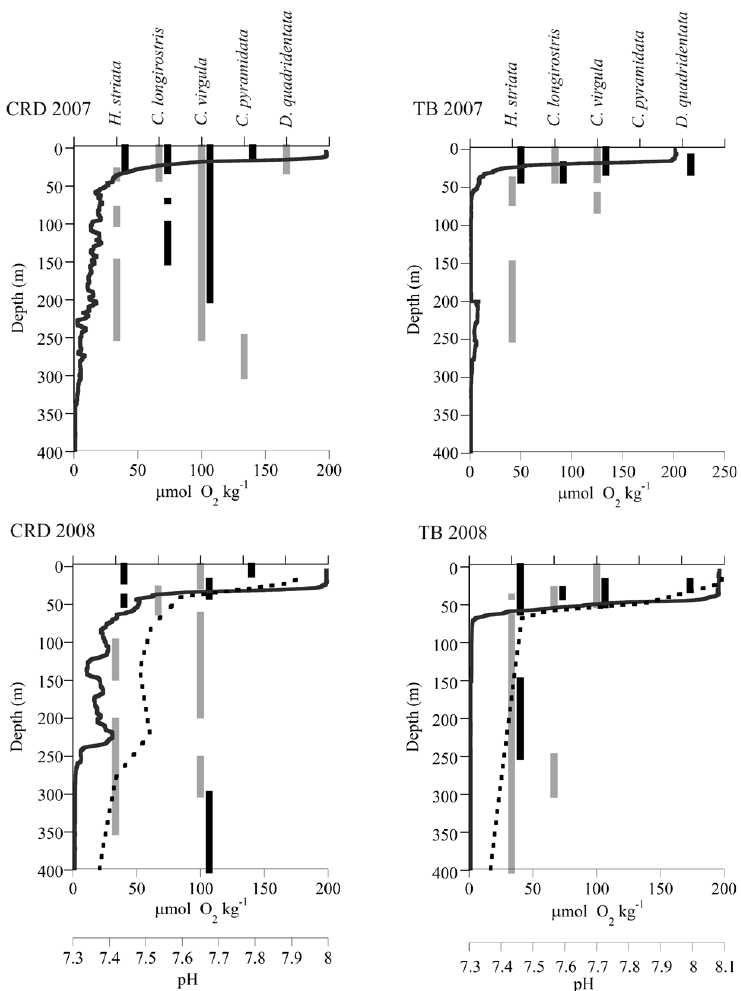
Fig. 5. The day (grey bar) and night (black bar) location of individual tropical pteropod species is plotted alongside the O 2 concentration at depth for 2007 and 2008 (solid line, µmolkg − 1 ) and pH in 2008 (dashed line). O 2 profiles are from MOCNESS data (assembled by R. Williams, D. Outram and K. Wishner), and pH was calculated by Byrn and Elliot using the standard SOP for pH analysis with m -cresol purple (unpublished